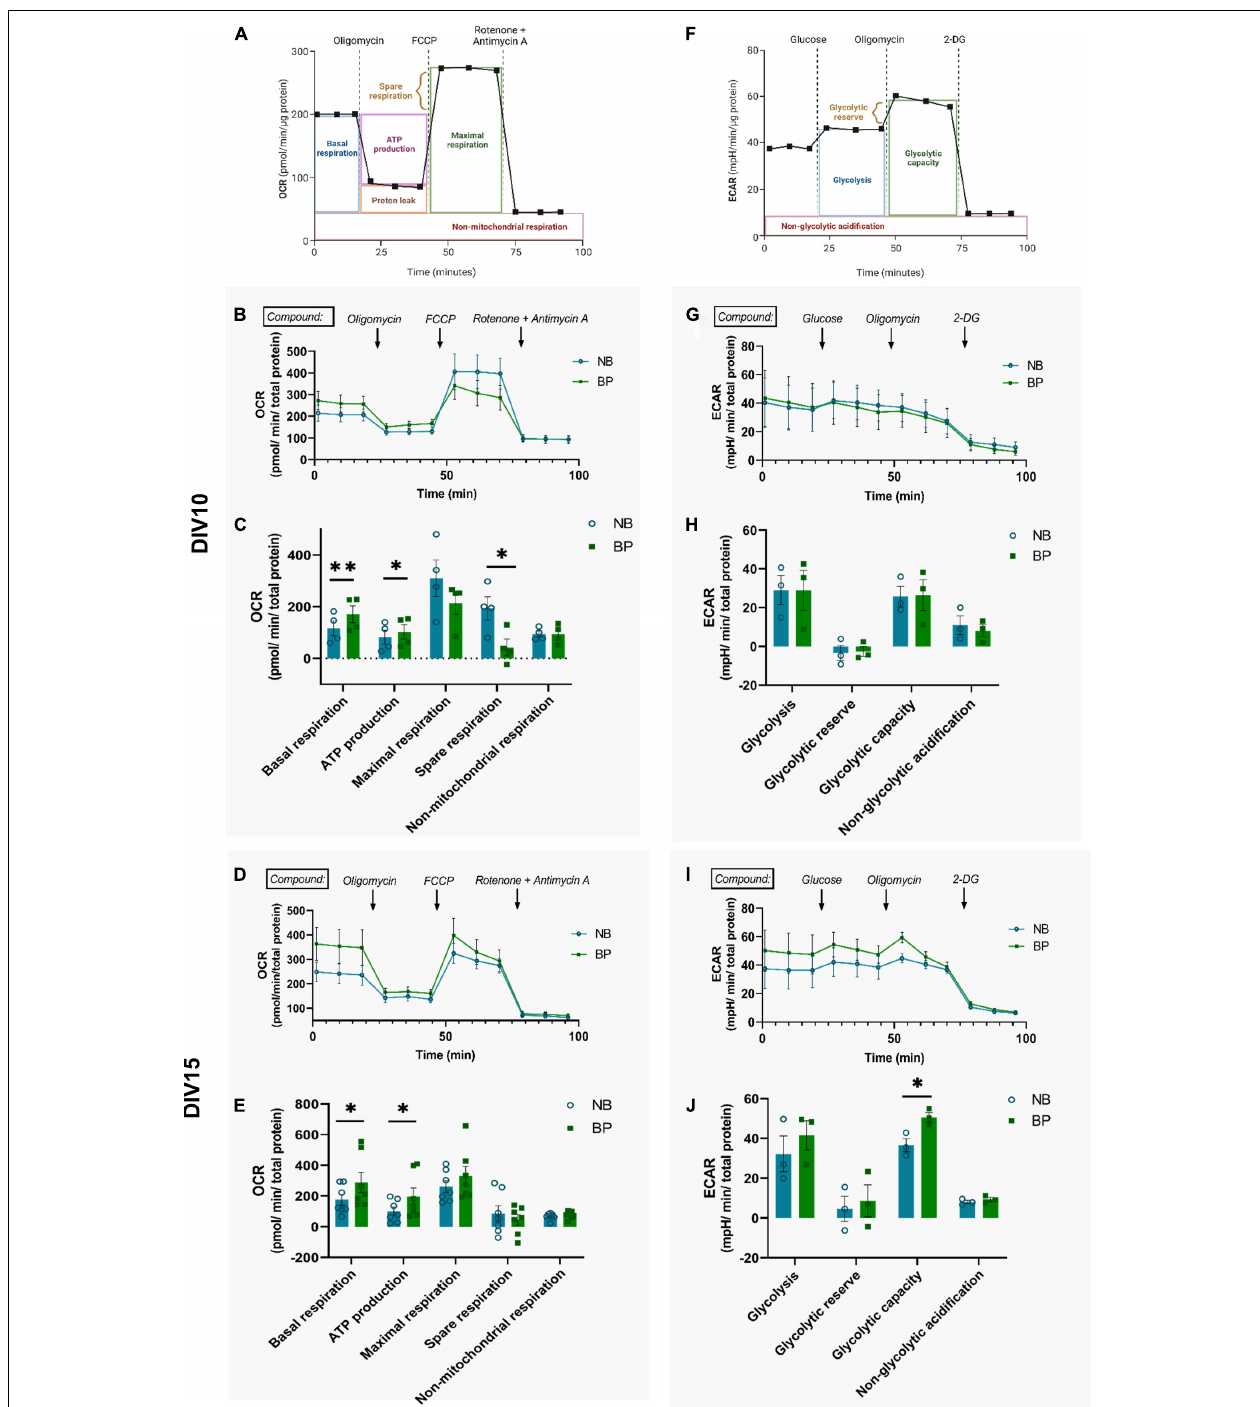
FIGURE 3 | Mouse neurons maintained in BP medium present increased OxPhos activity. Representative graphs and measure parameters of oxygen consumption rate (OCR) (A) and extracellular acidification rate (ECAR) (F) . Time-course OCR graphs of NB and BP neurons at DIV10 (B) and DIV15 (D) . Quantification of basal respiration, ATP production on response to oligomycin, maximal and spare respiration on response to FCCP, and non-mitochondrial respiration on response to rotenone and antimycin A in NB and BP neurons at DIV10 (C) and DIV15 (E) ( n = 4–7 biological experiments). Time-course ECAR graphs of NB and BP neurons at DIV10 (G) and DIV15 (I) . Quantification of NB and BP neurons showing glycolysis after glucose stimulus, glycolytic reserve, and capacity after inhibition of mitochondrial respiration through oligomycin and non-glycolytic acidification after 2-Deoxy- D -glucose (2-DG), an analogue of glucose that inhibits glycolysis at DIV10 (H) and DIV15 (J) ( n = 3 biological experiments). All bar graphs show means ± SEM, determined using the two-sided unpaired student’s t -test, ∗ p < 0.05; ∗∗ p < 0.01.